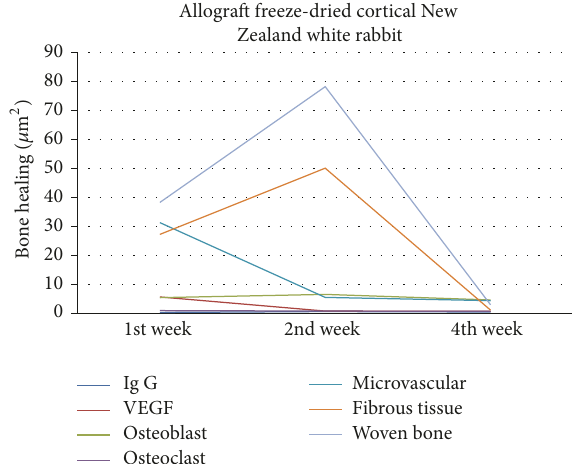
Figure 11: Bone healing in allograft freeze-dried cortical New Zealand white rabbit group.